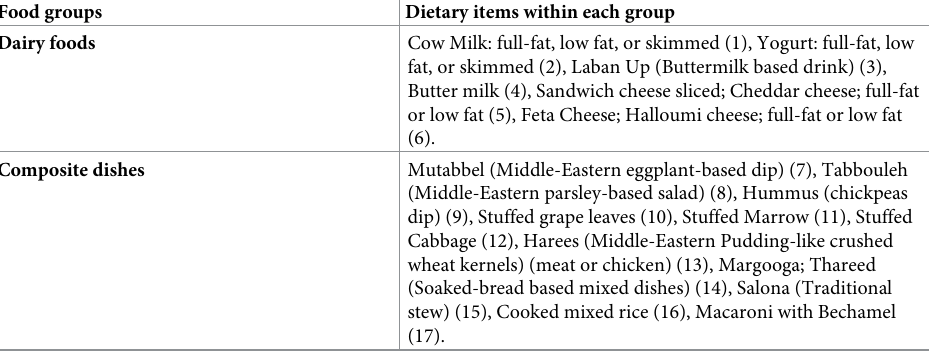
Table 1. List of all the 139 foods within the 13 food groups in the AE-FFQ. Food groups Dietary items within each